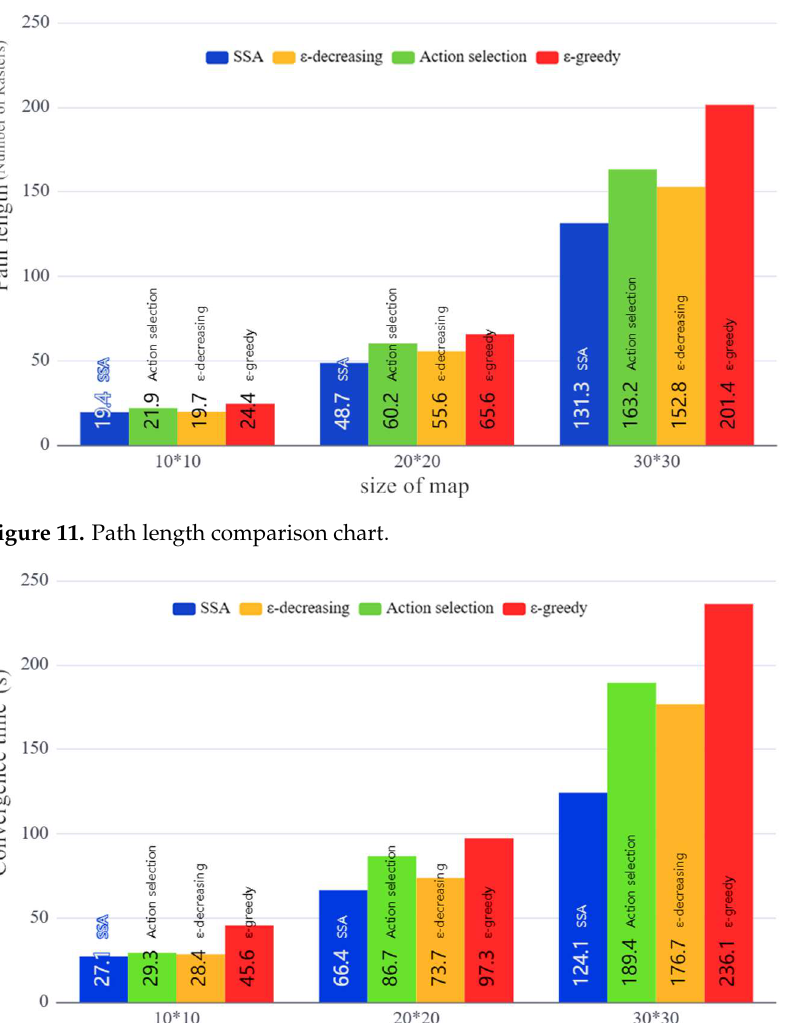
Figure 11. Path length comparison chart.